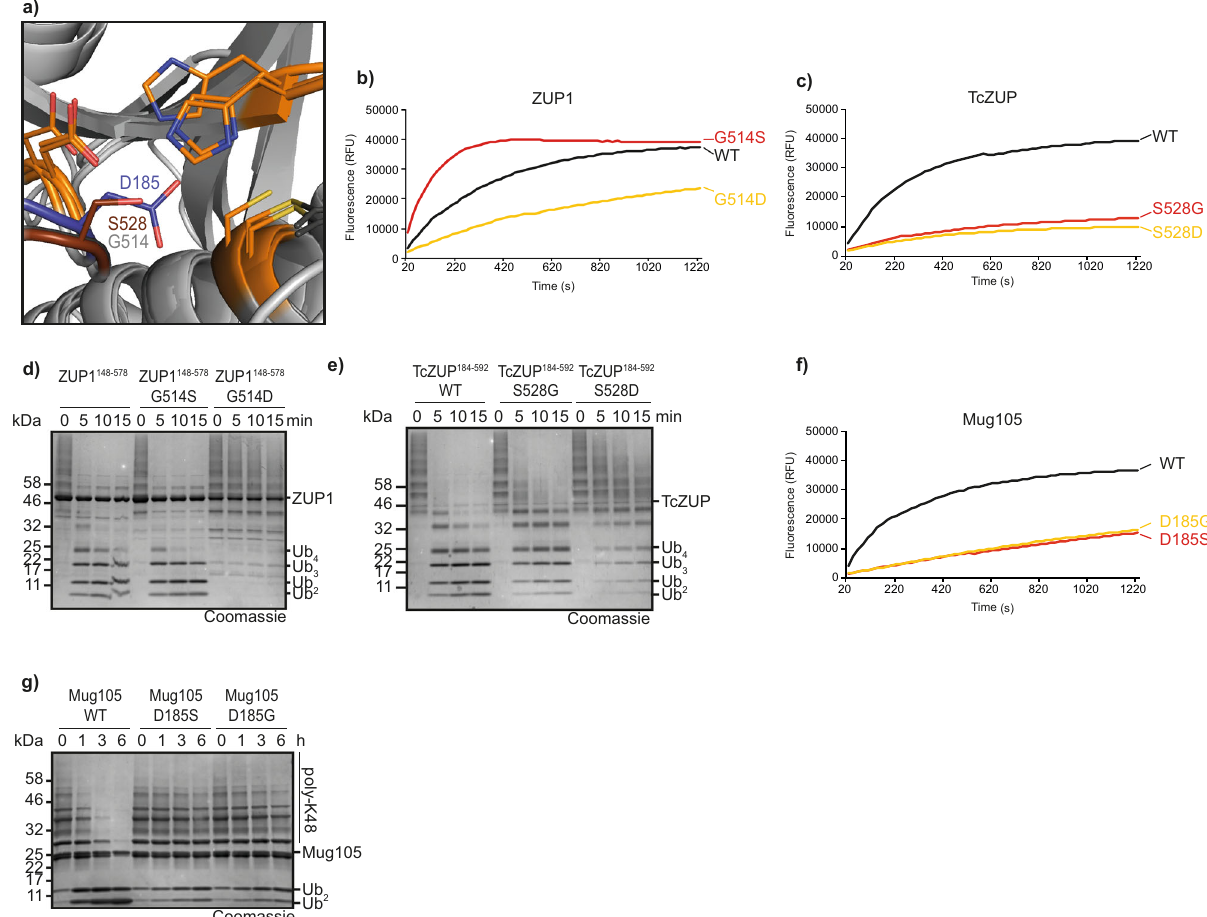
Fig. 4 Identi fi cation and importance of the oxyanion hole. a Superposition of ZUP1 (PDB:6EI1), TcZUP, and Mug105 active sites. The catalytic core domain is shown in cartoon representation and colored light gray. The catalytic triads are shown as sticks and colored orange. Ser-528 of TcZUP (brown) is in a suitable position to stabilize the tetrahedral reaction intermediate. The corresponding residues Gly-514 (ZUP1) and Asp-185 (Mug105) are shown as sticks and colored light gray and blue, respectively. b , c Activity of ZUP1 148 – 578 ( b ) and TcZUP 184 – 592 ( c ) oxyanion hole mutants against RLRGG-AMC. The RFU values shown are the means of triplicates. d , e Activity of ZUP1 148 – 578 ( d ) and TcZUP 184 – 592 ( e ) oxyanion hole mutants against K63-linked Ub 6 + chains. f , g Activity of Mug105 oxyanion hole mutants against RLRGG-AMC ( f ) or K48-linked poly-ubiquitin chains ( g ). The RFU values shown are the means of triplicates. Source data are provided as a Source Data fi